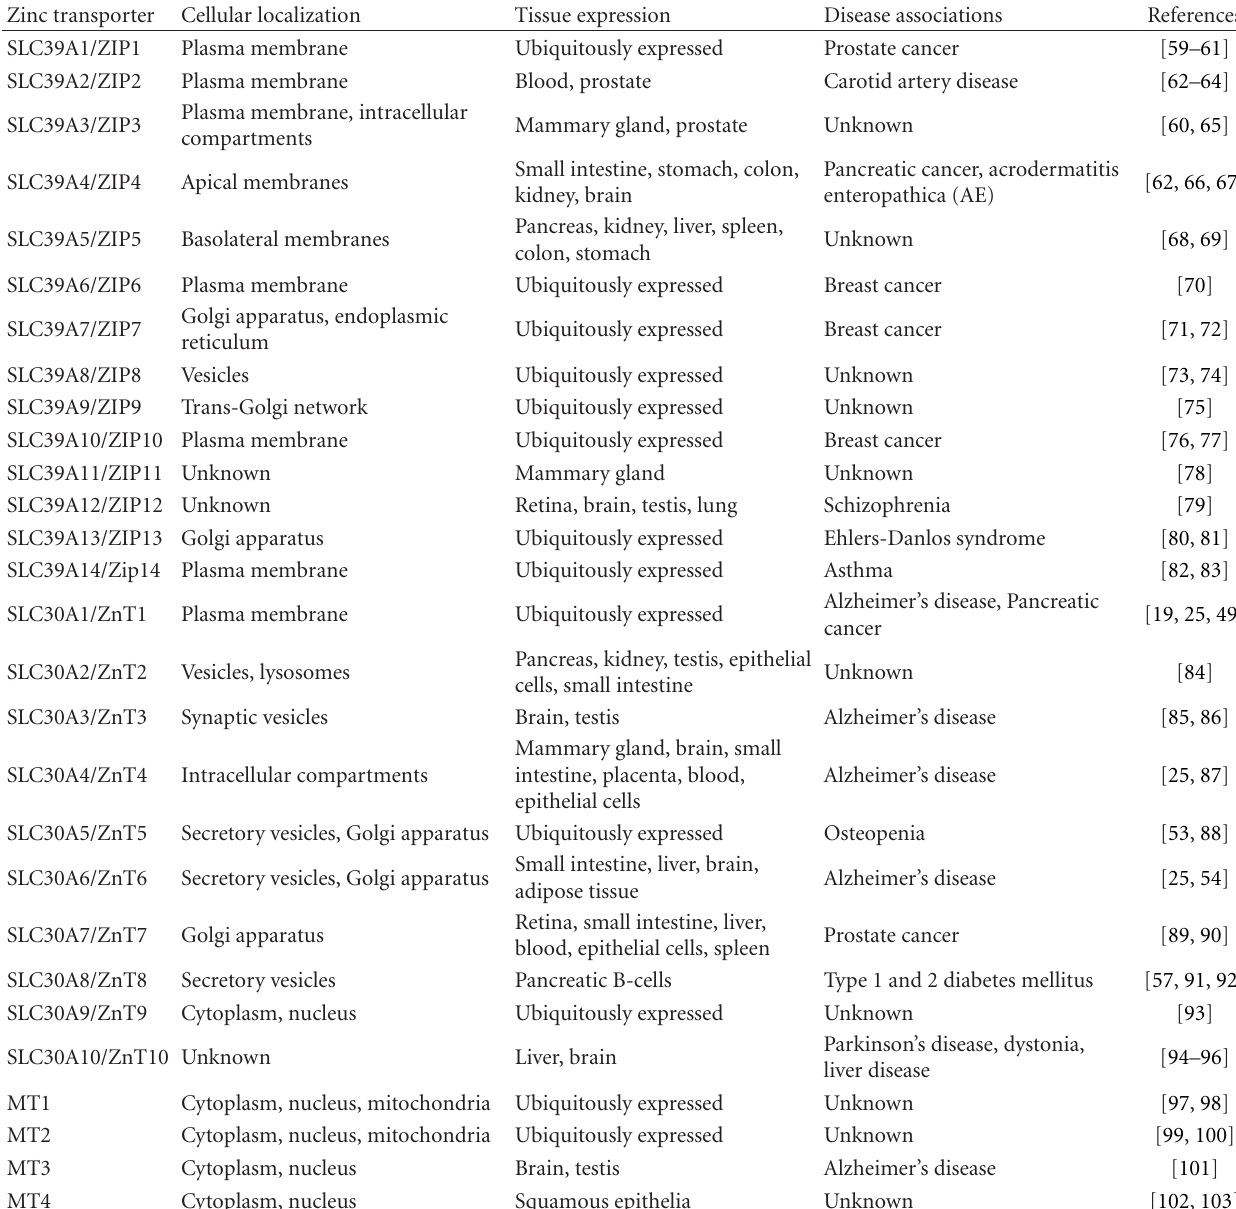
Table 1: Zinc transporters, cellular location, tissue-specific expression, and disease